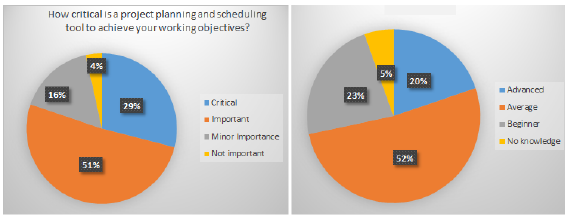
Figure 2. MS Project Survey - Importance of planning and scheduling tools and user